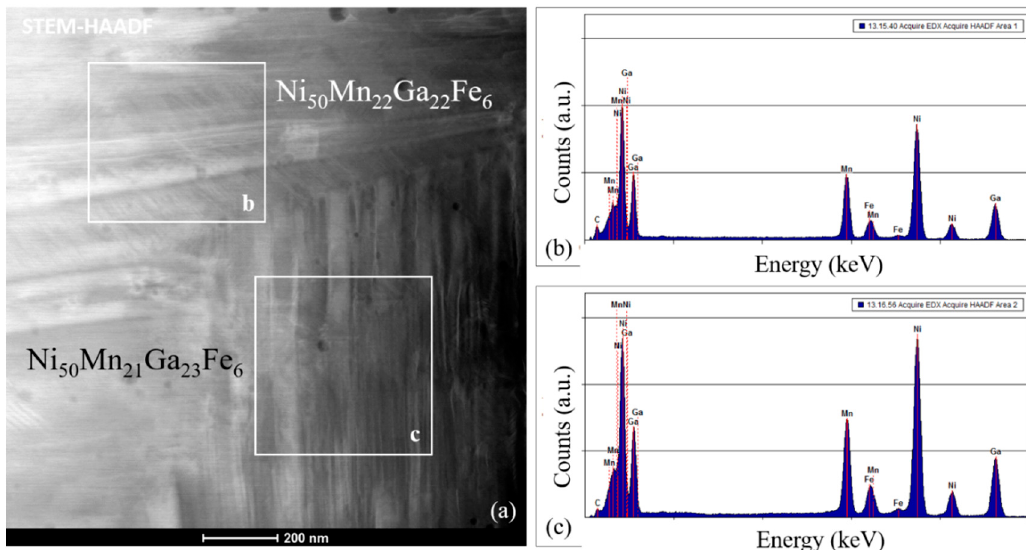
Figure 7. Scanning transmission electron microscopy image ( a ) and energy dispersive spectra from areas ( b , c ) corresponding to area marked with rectangle in ( a ) of as laser melted Ni-Mn-Ga-Fe powder.